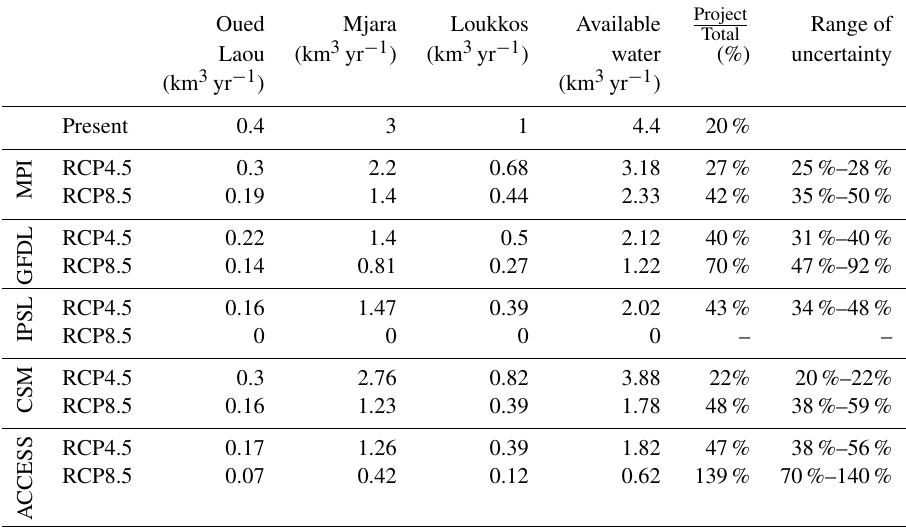
Table 7. A summary of the expected loss of water in the three watersheds, and how the project will affect water availability. We assume the current project design of transferring 0.86km 3 yr − 1 . The available water refers to how much water is available in the whole study region. ( Project ) is the ratio of the amount of water that will be allocated to the project, if the project remains in its current form, over the potential Total total available water in the study region following each simulation. Based on the uncertainty range given by the regression in the estimation, we could quantify the uncertainty in our results, as presented in the right-hand column. Oued Mjara Loukkos Available Project Range of Total